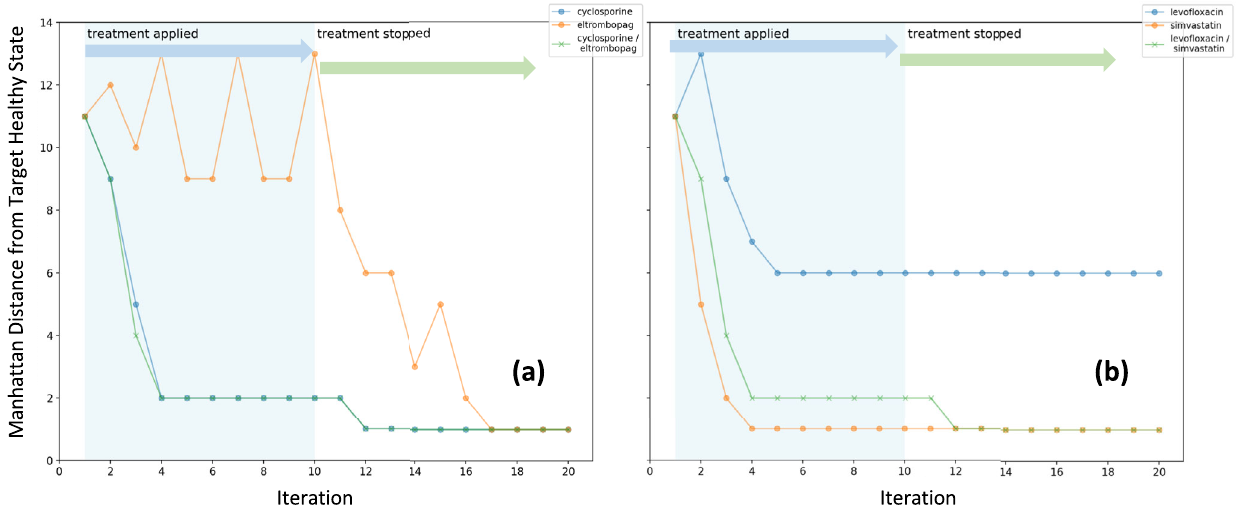
Fig. 7 Simulating ineffective drug pairs. Discrete event simulation using synchronous state transition update of host immune network showing the overall Manhattan distance from the target immune resting state as a function of iteration. An idealized antiviral is applied to an initial persistent state approximating cytokine storm along with a cyclosporine alone, eltrombopag alone or a combination of both, and b simvastatin alone, levo fl oxacin alone or a combination of